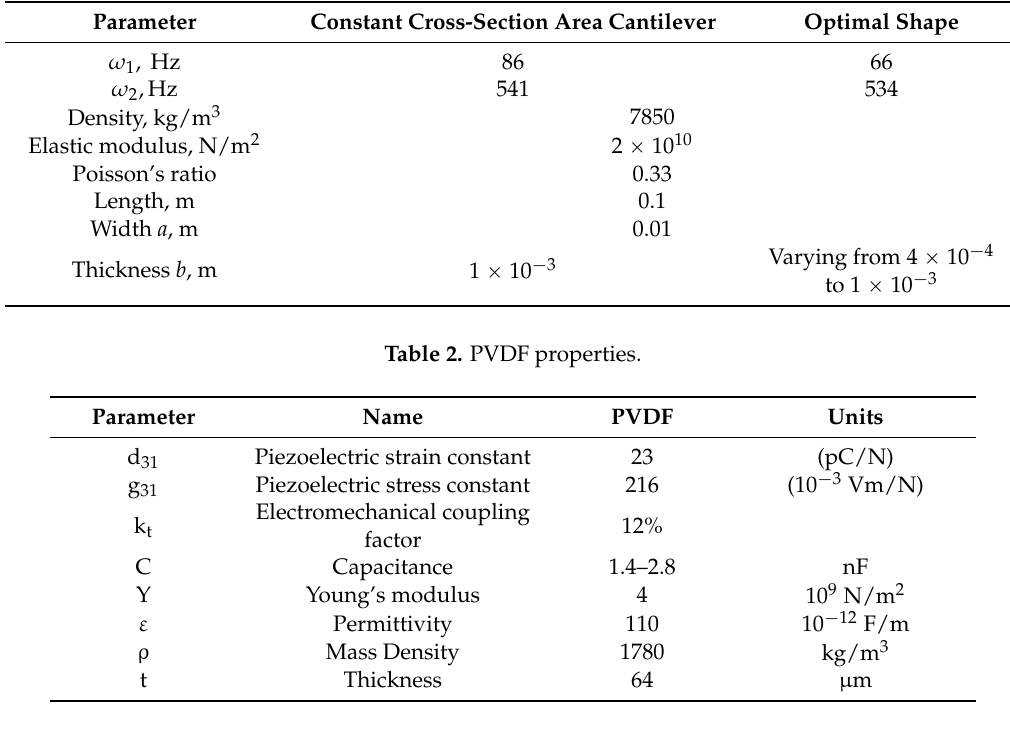
Figure 1. Piezoelectric cantilever under translational and small rotational base motions (adapted from [17]). PVDF, polyvinylidene fluoride. Table 1. Mechanical and geometrical properties of the considered cantilever setups.